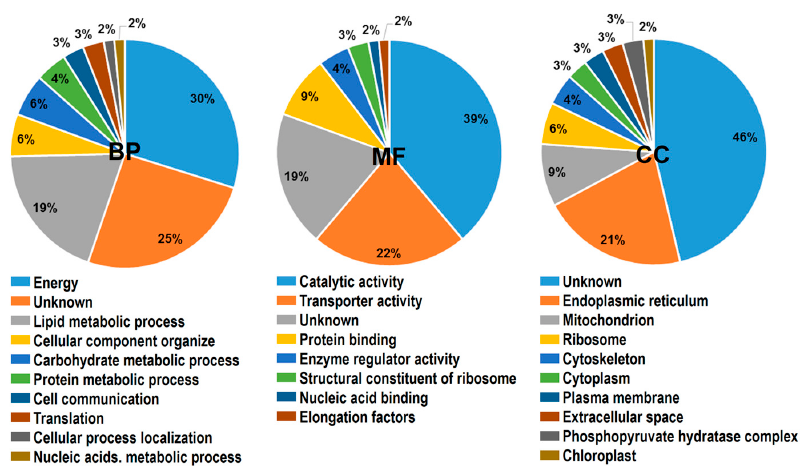
Figure 3. Functional annotation of identified DEPs based on Gene Ontology (GO) categorization. Results are summarized for three main GO categories: biological process (BP), molecular function (MF), and cellular component (CC).